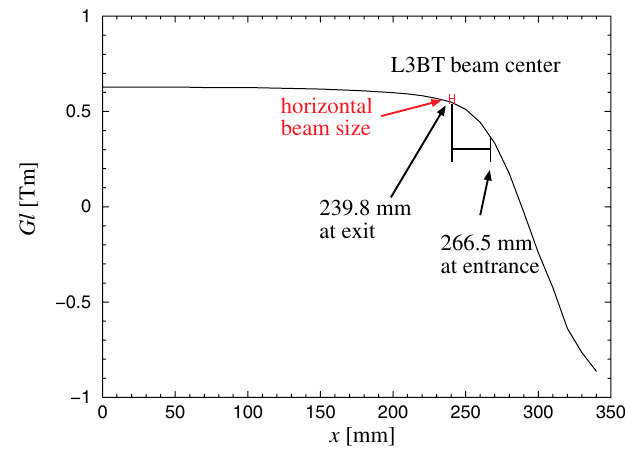
FIG. 8. (Color) Gl distribution of QFL at y (cid:4) 0 . The incoming beam center passes at x (cid:4) 266 : 5 mm for the entrance and at x (cid:4) 239 : 8 mm for the exit of